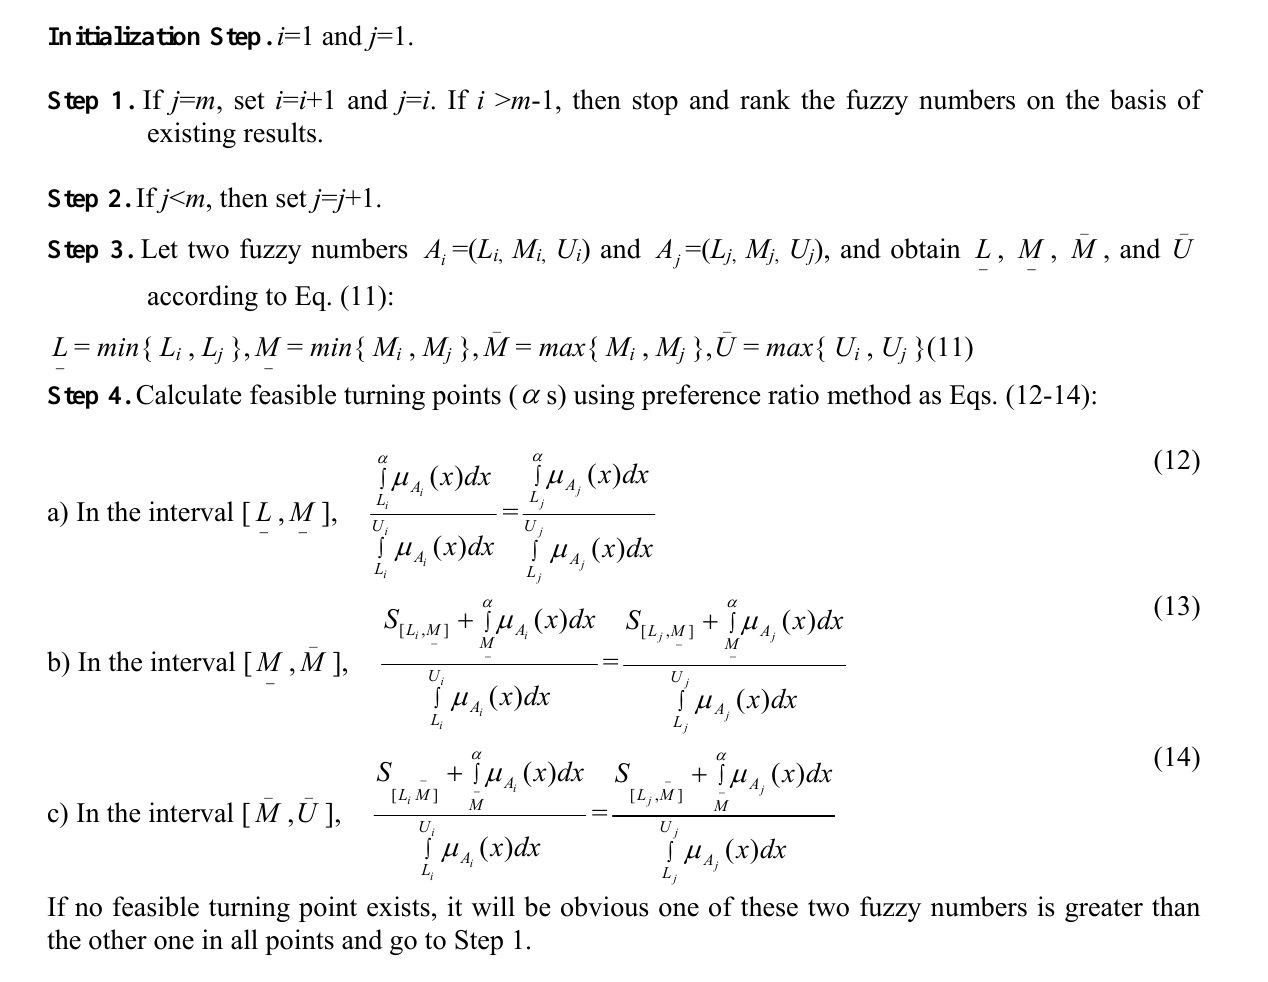
Proposed algorithm: preference ratio based on utility function